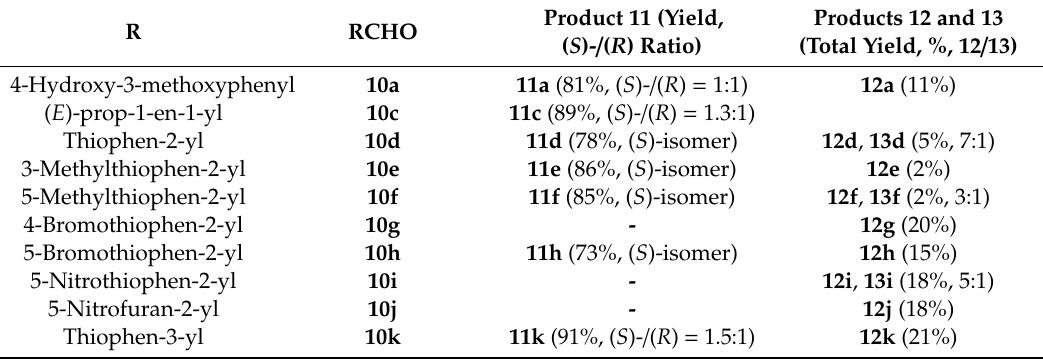
Product 11 (Yield, Products 12 and 13 ( S )- / ( R ) Ratio) (Total Yield, %, 12 /